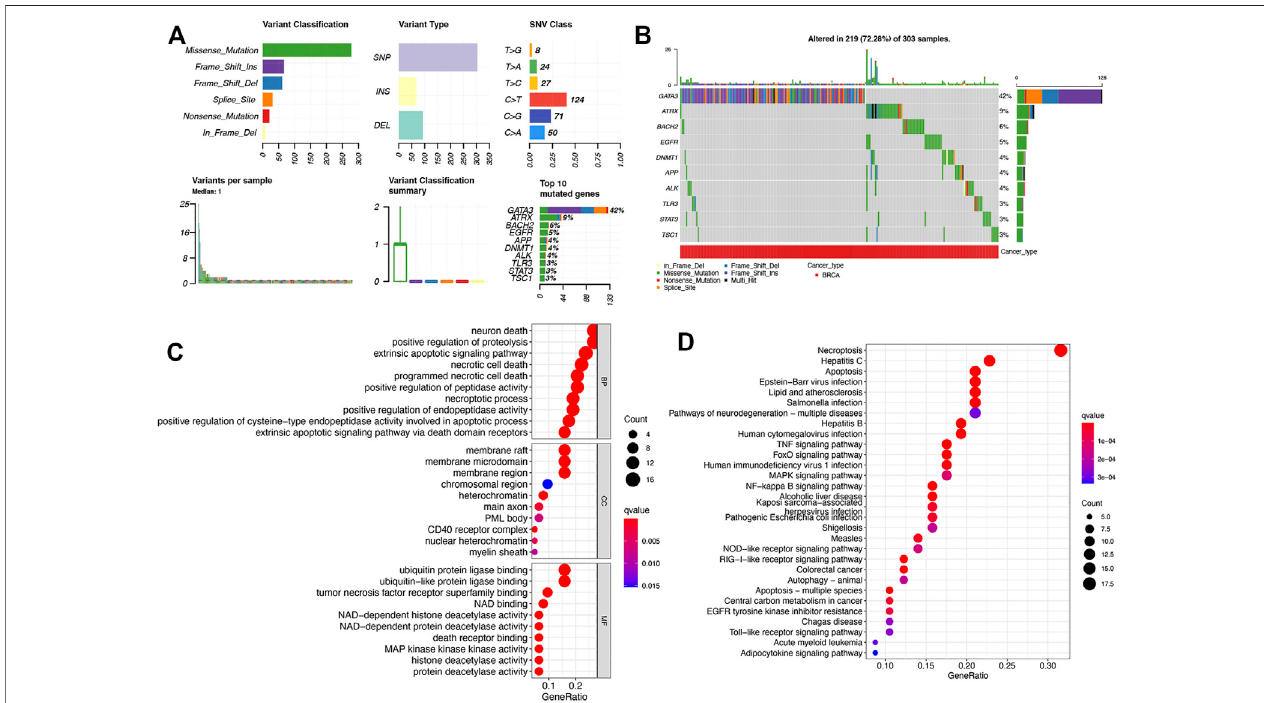
FIGURE2| Geneticmutationandfunctionalenrichmentanalysisofnecroptosis-relatedgeneinBRCA. (A – B) Thegeneticmutationofnecroptosis-relatedgenesin BRCA. (C – D) The enriched items in gene ontology and Kyoto Encyclopedia of Genes and Genomes analysis. BP, biological process; CC, cellular component; MF, molecular